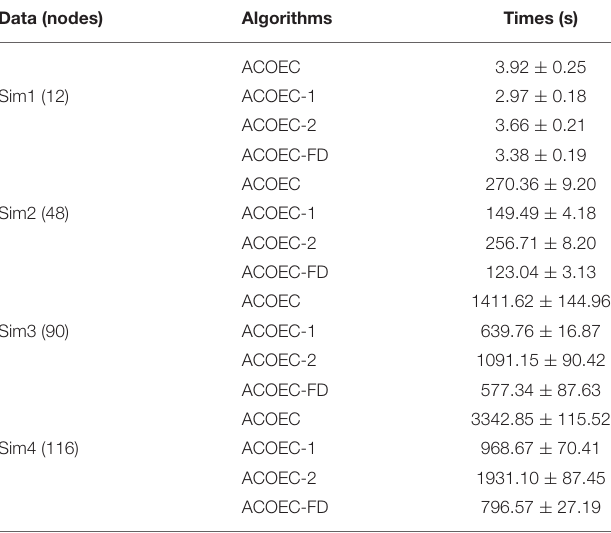
TABLE 2 | Contributions of two new strategies on time performance. Data